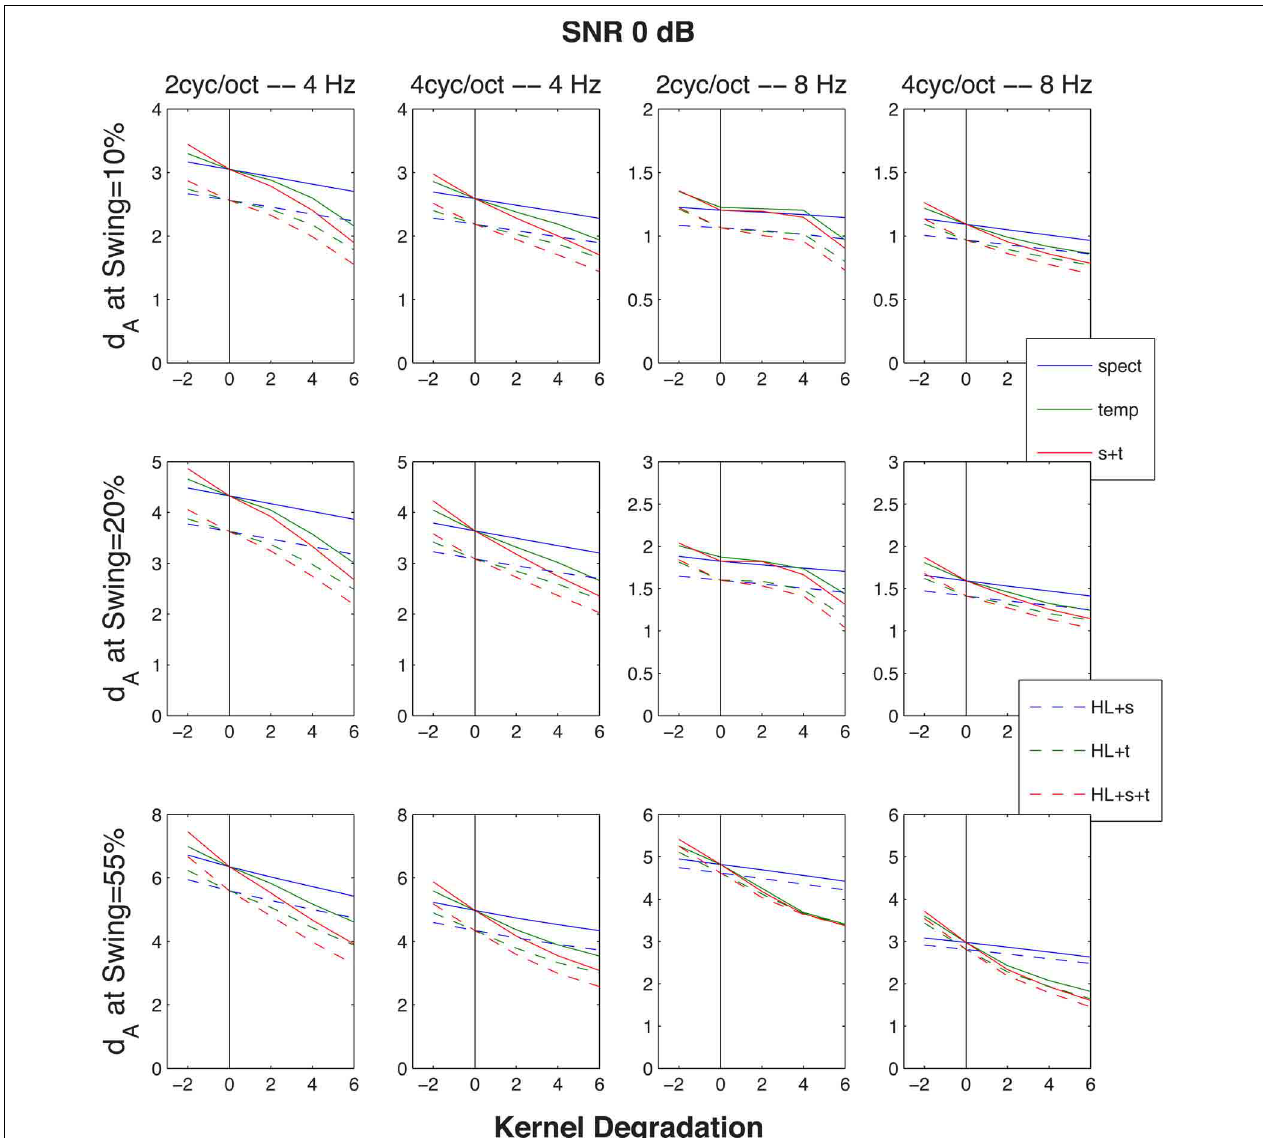
FIGURE 7 | Similar to Figure 6, except that the cumulative normalized Euclideandistancesd A betweenSTRFpatternsgeneratedbytheup-down and the down-up targets were evoked by the same target-distracter SNR of 0dB, across three FM excursion extents (10, 20, and 55% maximum